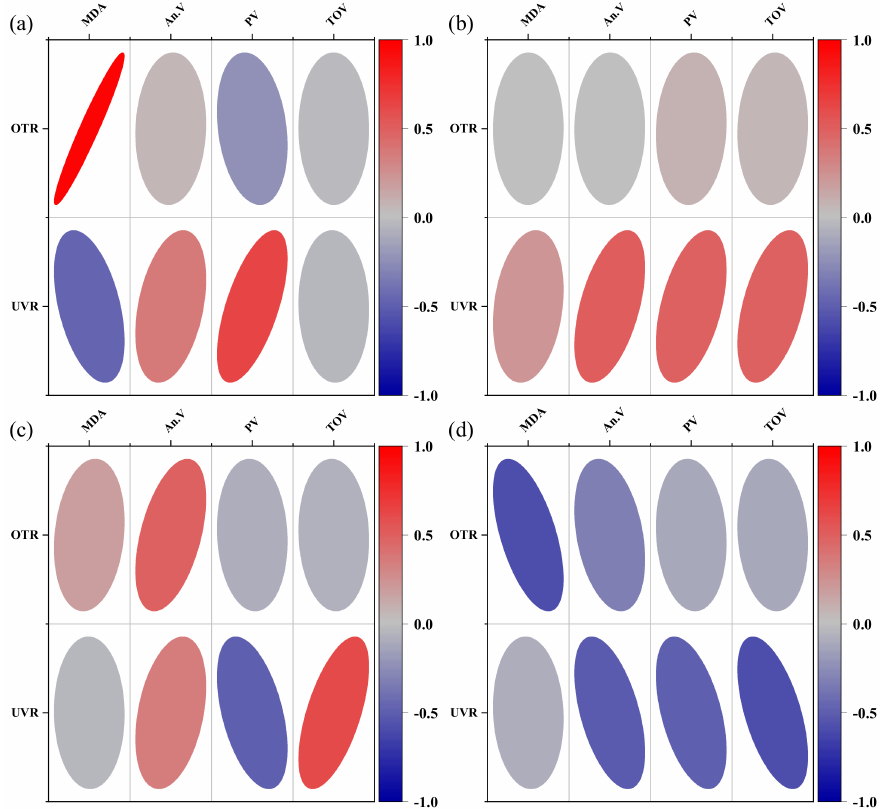
Figure 9. Correlation of grease oxidation indicators with key film properties. ( a ) 3d, ( b ) 6d, ( c ) 9d, ( d )